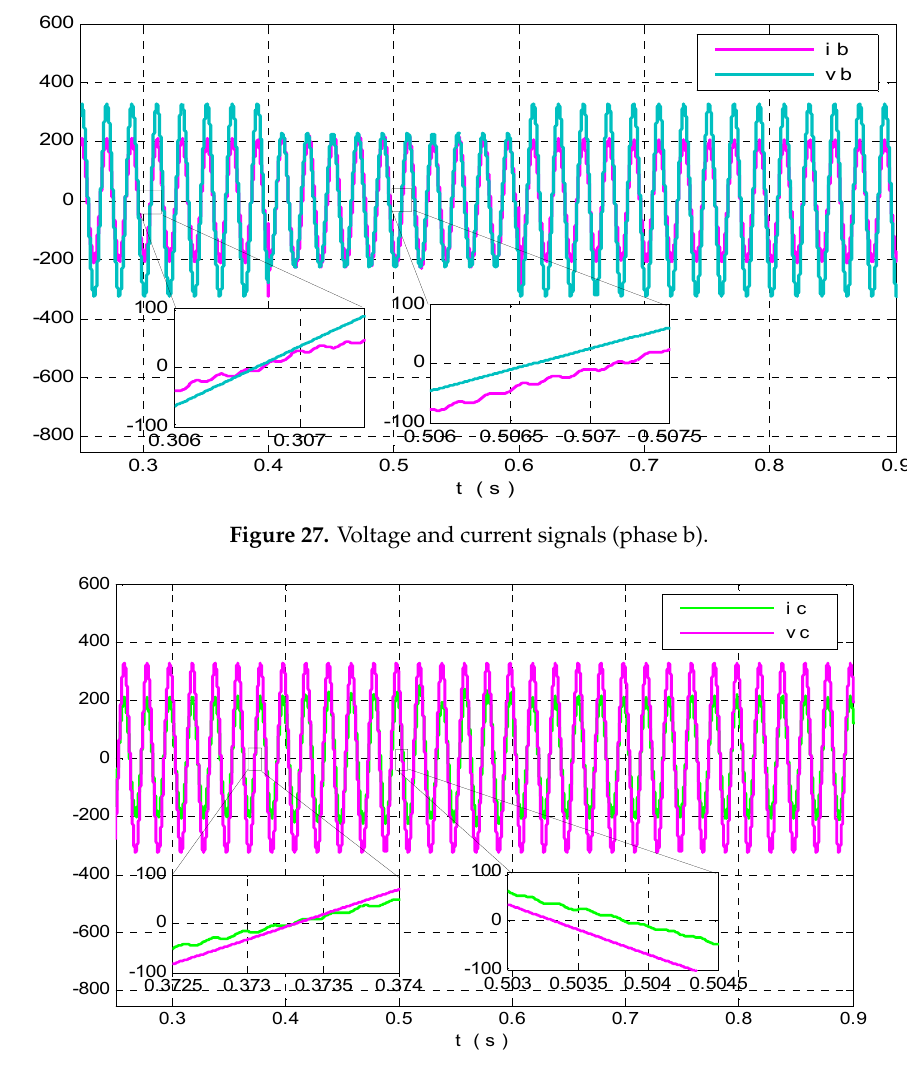
Figure 28. Voltage and current signals (phase c).